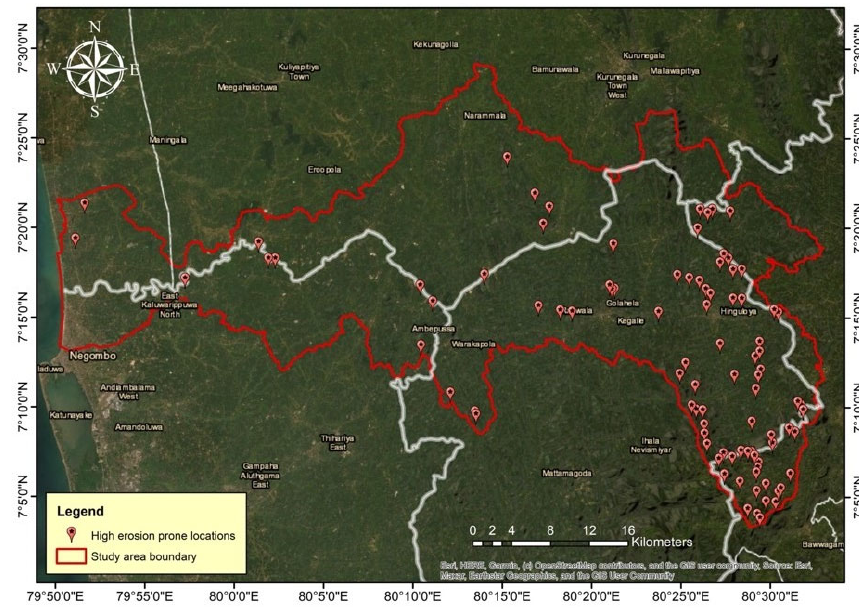
Figure 14. Extremely high erosion prone locations of Maha Oya River